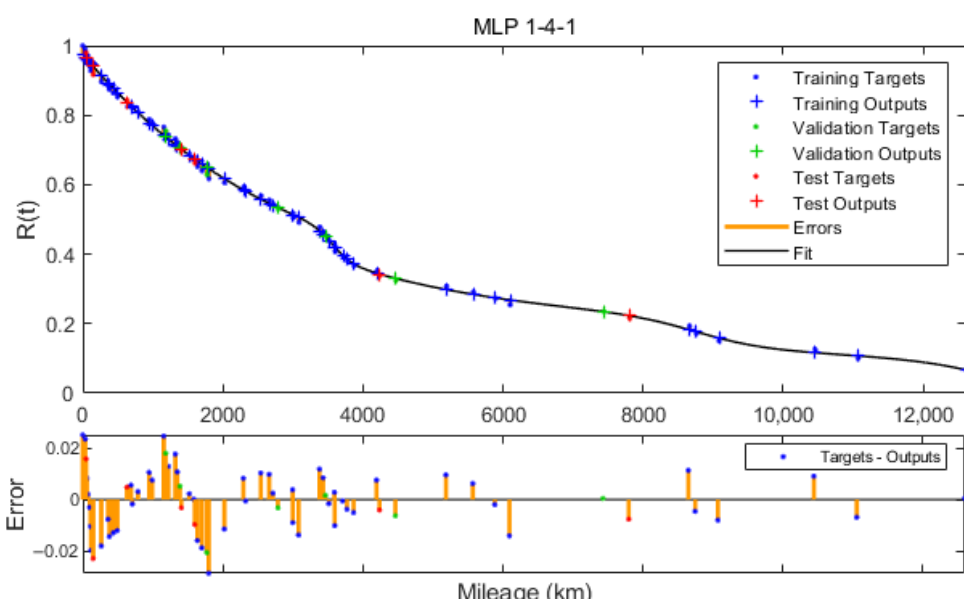
Figure A3. Reliability function approximated by MLP 1-4-1.